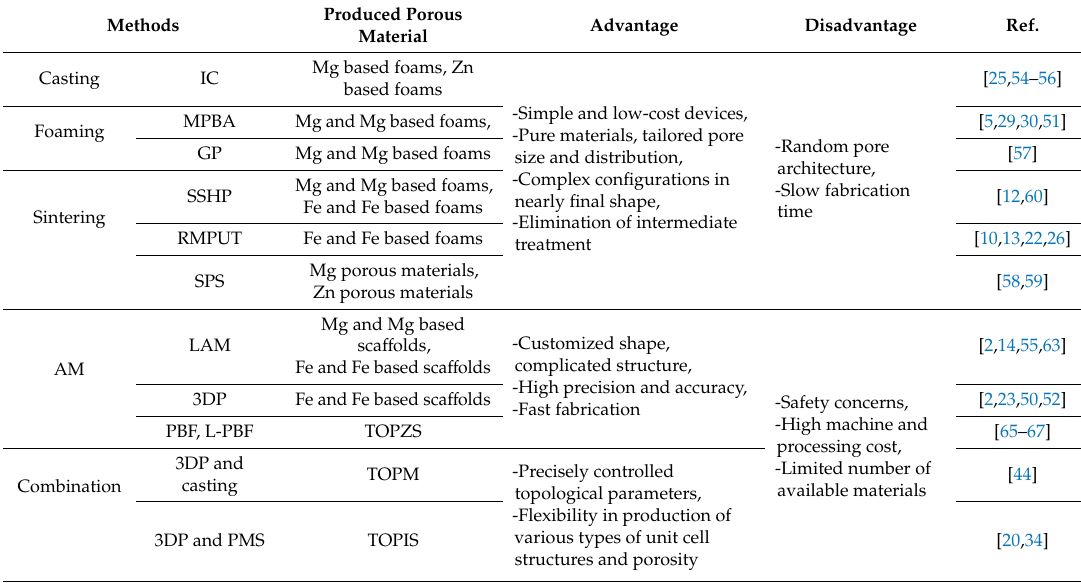
Table 1. Summary of the advantages and disadvantages of common fabrication methods of metallic foams for biomedical